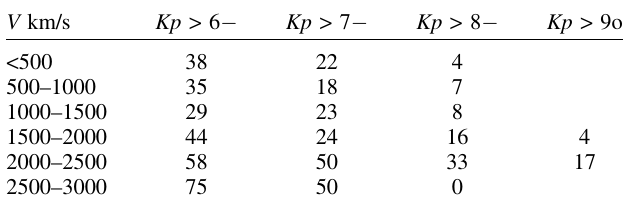
Table 1. Percentage likelihood of Earth-directed CME (total of 261) causing a geomagnetic storm, based on 500 km/s bins of LASCO speed